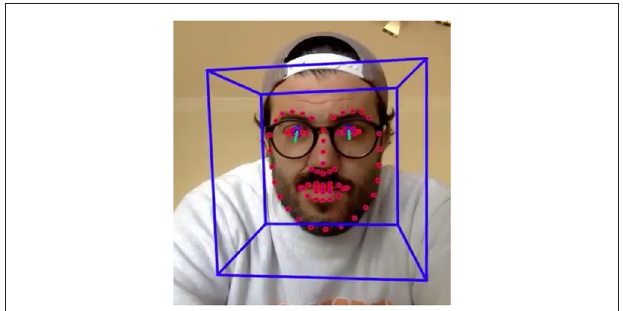
FIGURE 1 | Example of OpenFace output including facial landmark detection, head pose estimation, facial action unit recognition, and eye-gaze estimation. These metrics are computed for each frame of the video. Depicted is a single frame from the